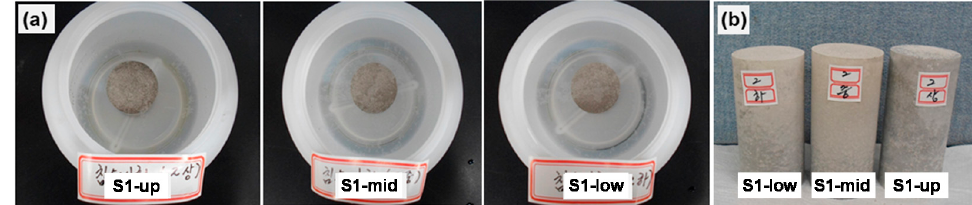
Figure 4. ( a ) Images of representative samples subjected to the water immersion test and ( b ) Samples after the test.